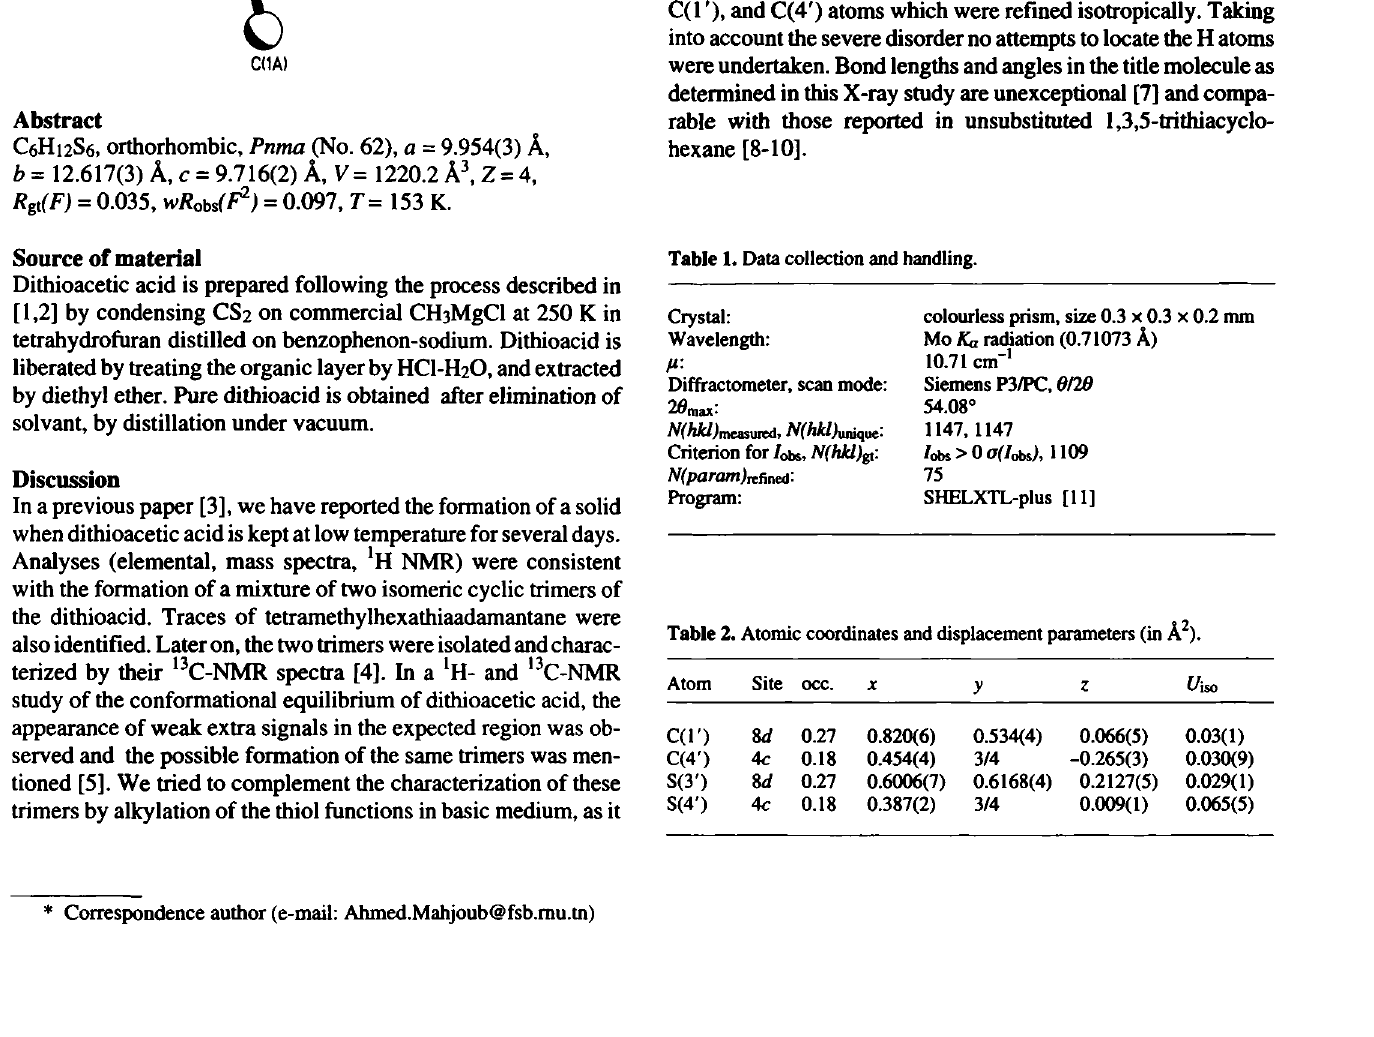
Table 1. Data collection and handling.